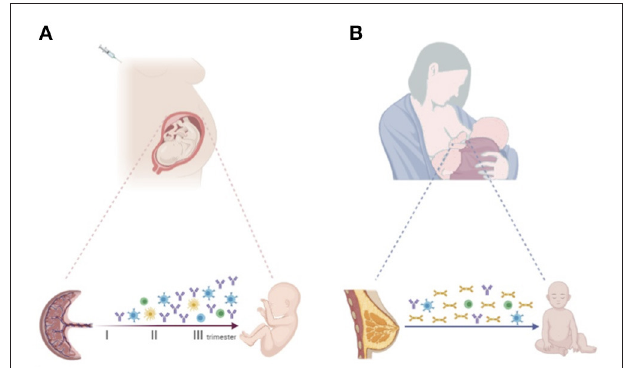
FIGURE 1 | (A) Progressive increase of vaccine-specific antibody production and transplacental transfer after maternal immunization during pregnancy. Maternal vaccination may also impact the transfer of maternal immune cells to the offspring, priming the developing fetal immune system. (B) Breastfeeding enables the transfer of vaccine-specific maternal antibodies, mainly sIgA, and immune cells secreted through colostrum and breast milk to the infant. Created with